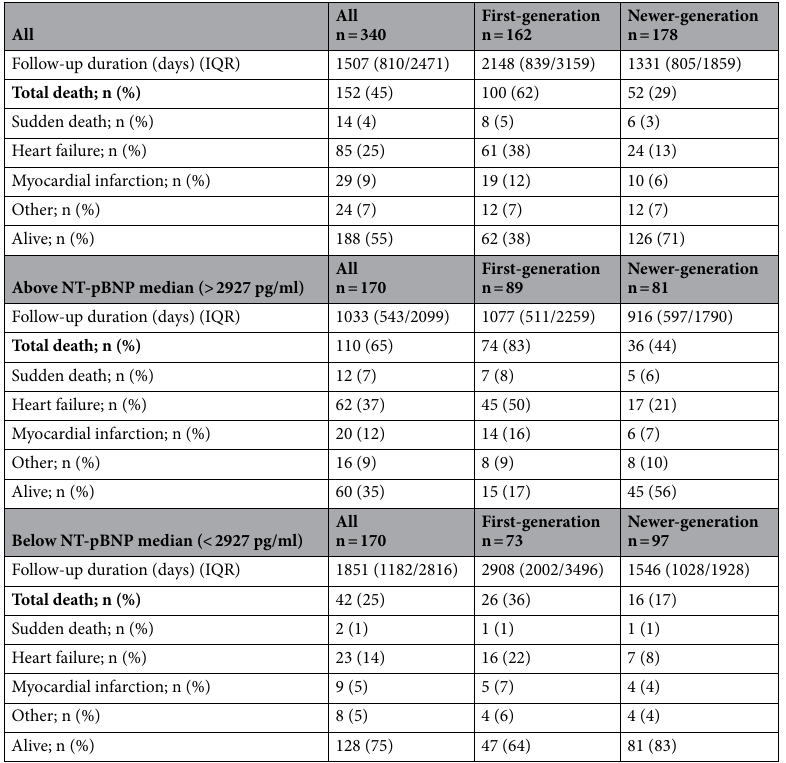
Table 4. Cause of death. CABG coronary artery bypass graft, DES drug-eluting stent, NT-proBNP N-terminal proB-type natriuretic peptide, PCI percutaneous coronary intervention.